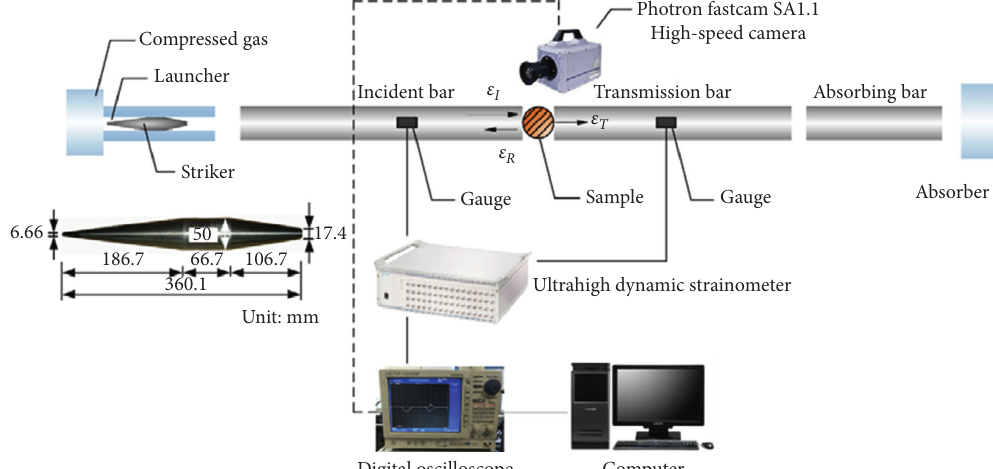
Figure 2: Dynamic Brazilian test with the SHPB